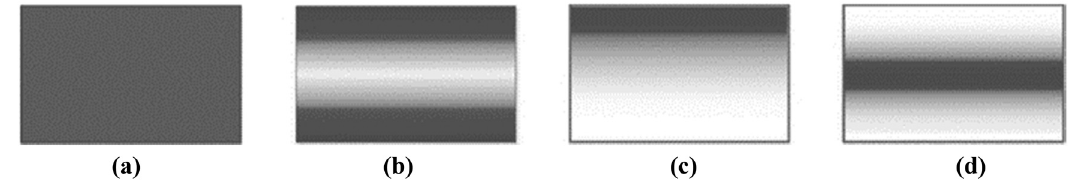
Figure 6: Distinctive GPL distribution of FGP - GLPRC in di ff erent styles [ 26 ]